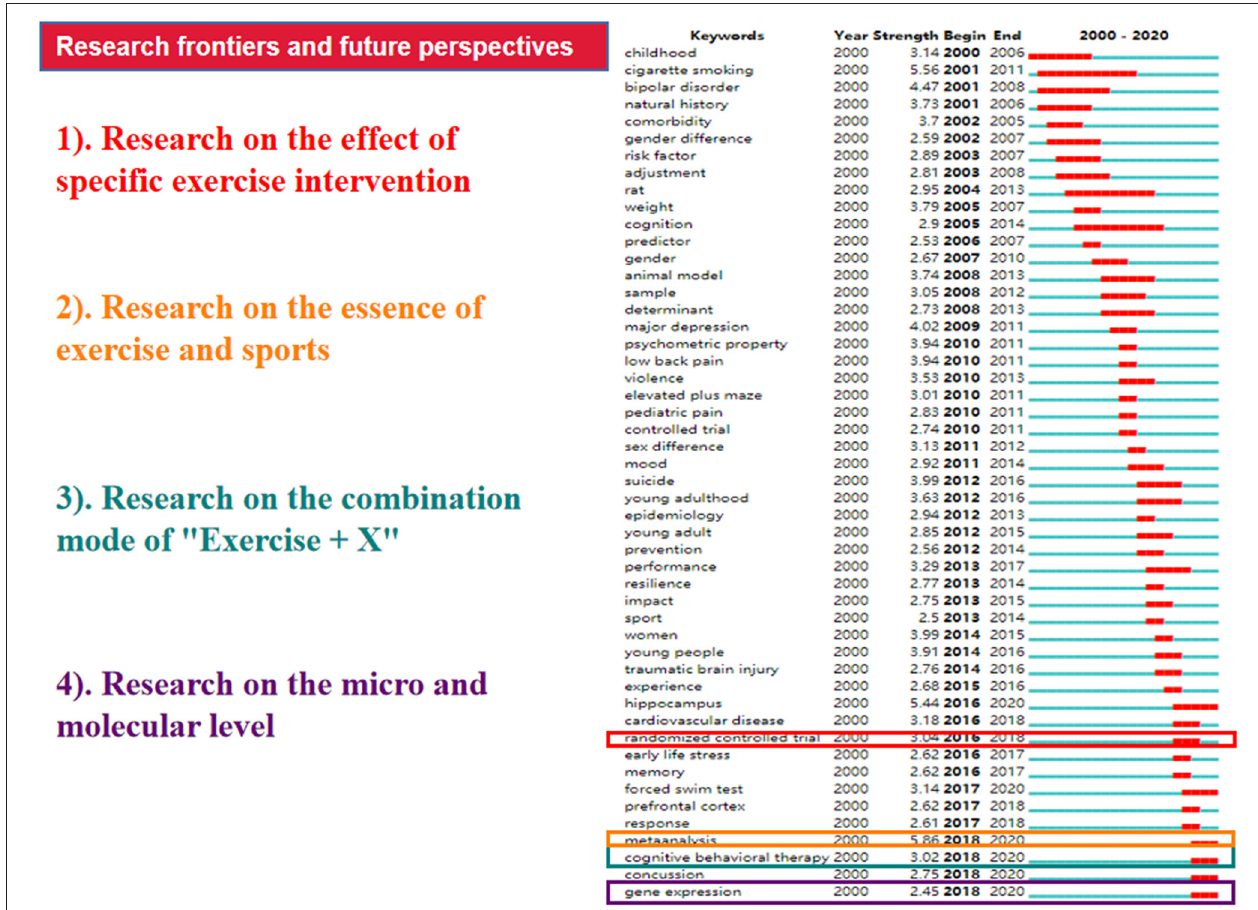
FIGURE 7 | Top 50 keywords with the strongest citation burst in exercise-depression-teenager research. provided by VOSviewer. As a consequence, a total of 121 frequently referred keywords were incorporated and 922